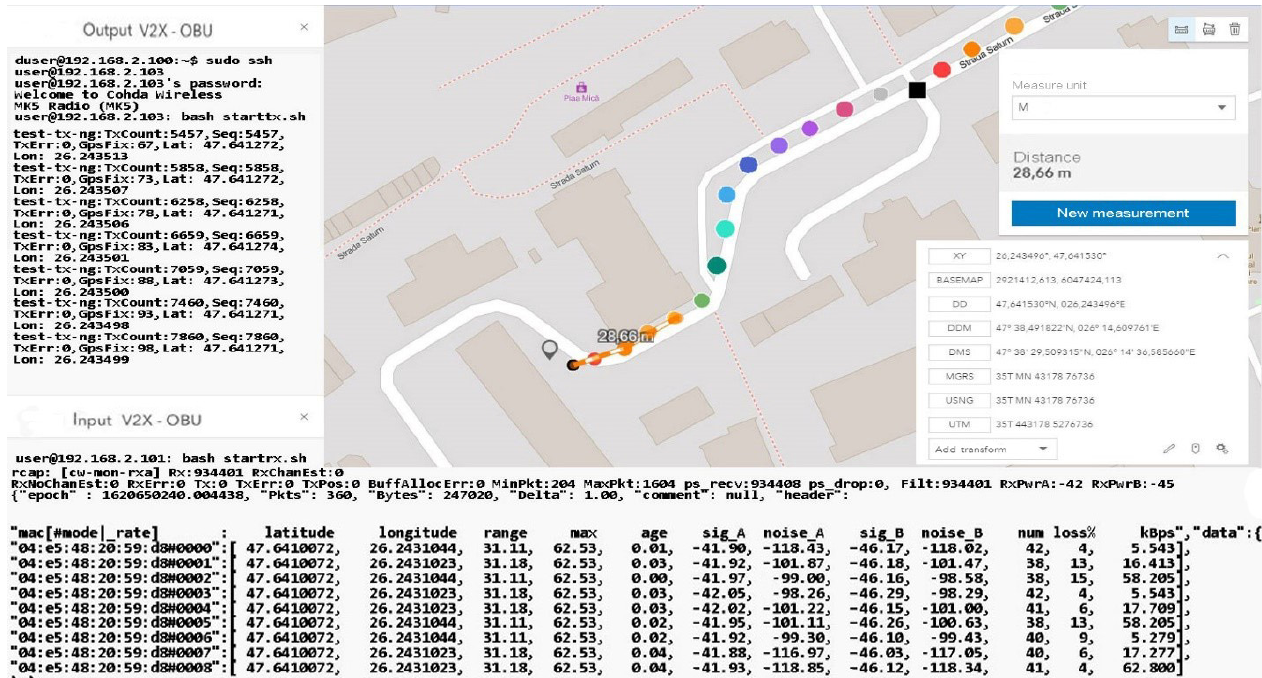
Figure 31. Simulated scenario at a distance of 30 m from the transmitter in a controlled environment.